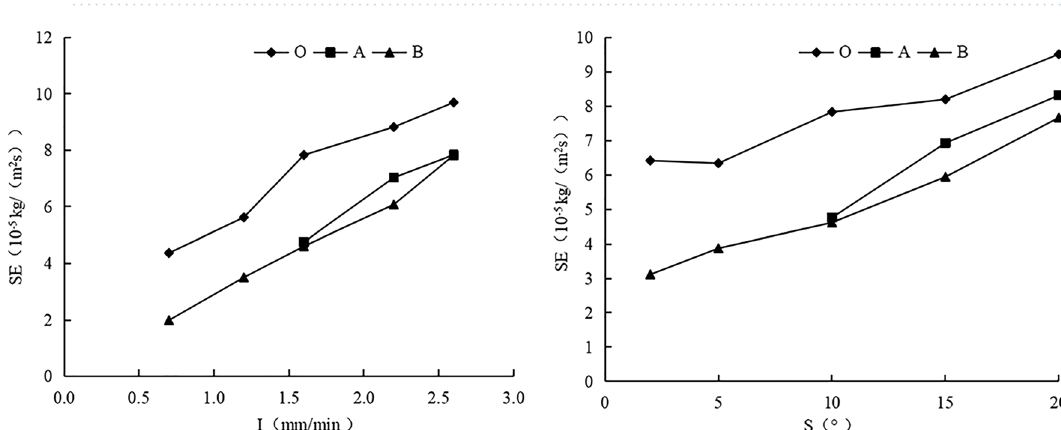
Figure 4. Variations of sheet erosion rate of three treatments with rain intensity or slope. O is bare slope, B is Prunella vulgaris combined with earthworm planting slope, A is Single planting prunella vulgaris